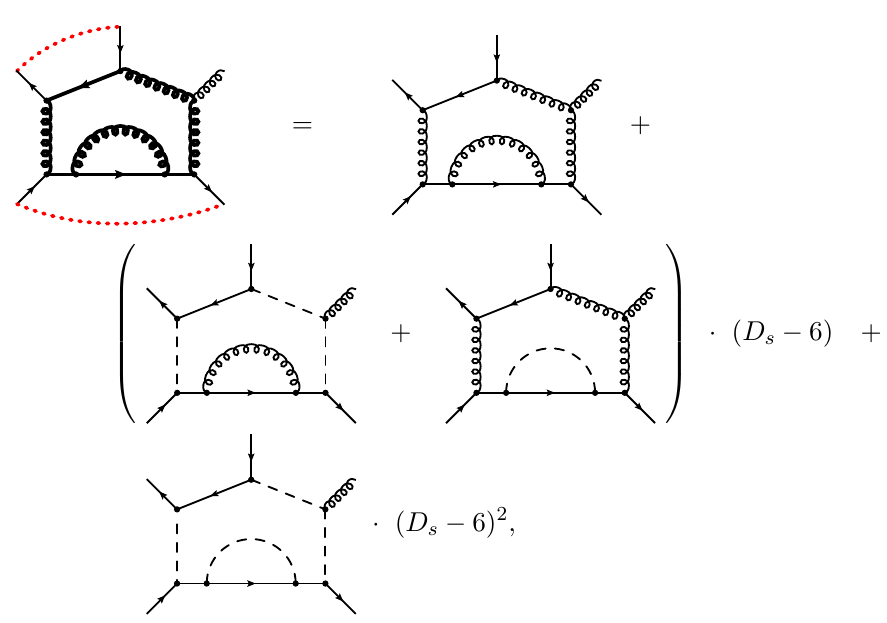
Figure 6 . Example of diagrams with scalar particles, representing the contributions to the coef- (cid:12)cients of ~ K i in eq. (3.2). The thick lines in the diagram on the left-hand side represent particles in arbitrary D s dimensions. The (red) dashed lines connecting external-quark lines represent the traces required to obtain the coe(cid:14)cient of the tensor structure of eq. (2.2b). All particles on the right-hand side are in six